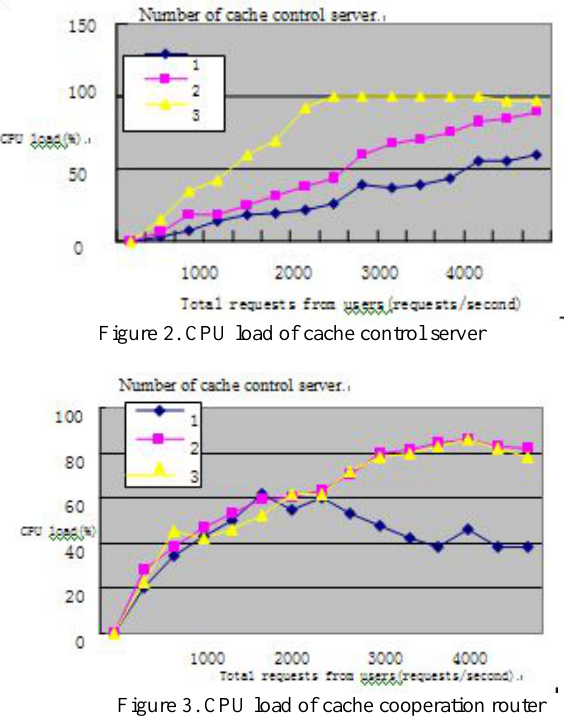
Figure 3. CPU load of cache cooperation